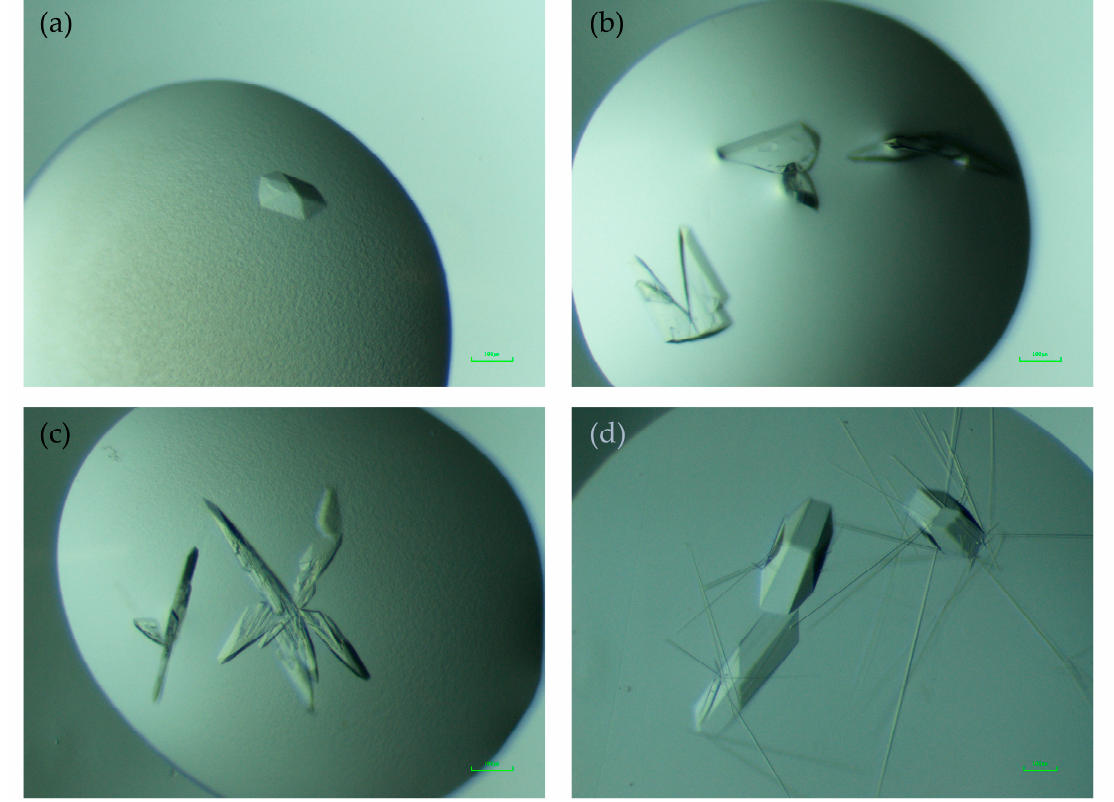
Figure 1. Crystal morphology of N His -Thal-RebH5. ( a ) Crystal of the described structure N His -Thal-RebH5 ( 1 ) with an almost hexagonal morphology and di ff raction to 1.63 Å. ( b ) Plate-shaped crystals of the described structure N His -Thal-RebH5 ( 2 ), which di ff racted to 1.84 Å. ( c ) Further examples of the various morphologies of N His -Thal-RebH5 crystals. ( d ) Crystals of untagged Thal-RebH5 (6IB5). Scale bar in green corresponds to 100 µ